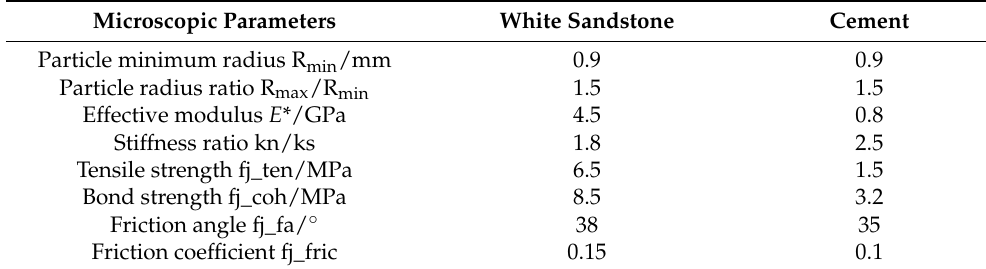
Table 3. Microscopic parameter values used in simulation.